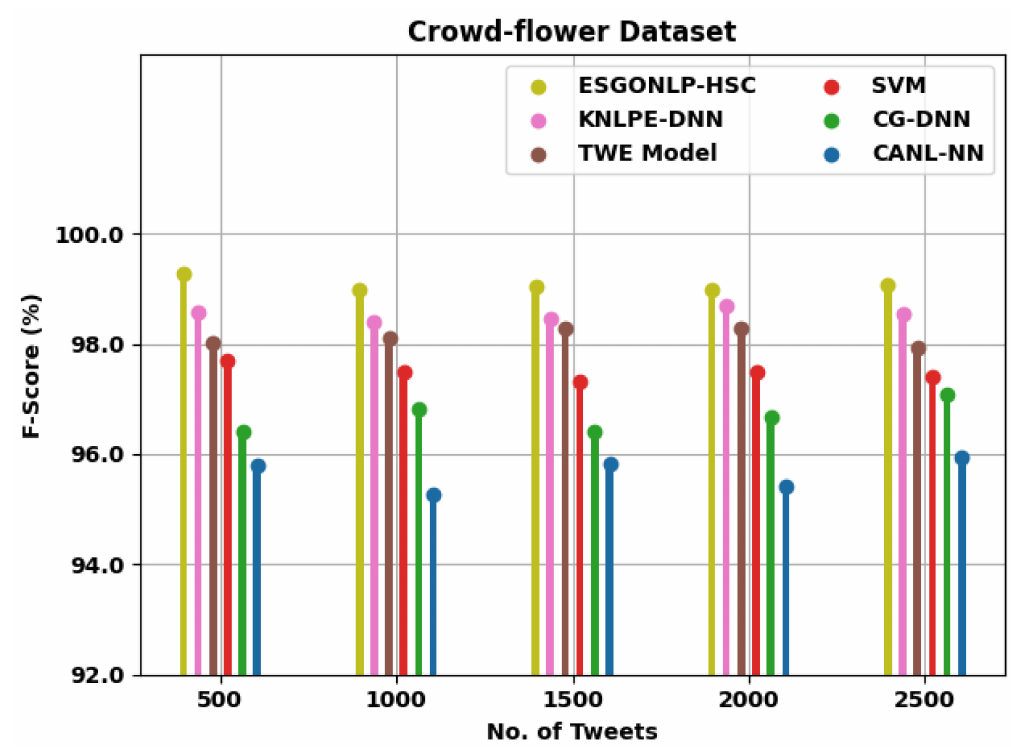
Figure 10. F score analysis of ESGONLP-HSC technique under Crowd-flower dataset. Table 5. F-score analysis of ESGONLP-HSC method with existing approach under Storm front and Crowd-flower